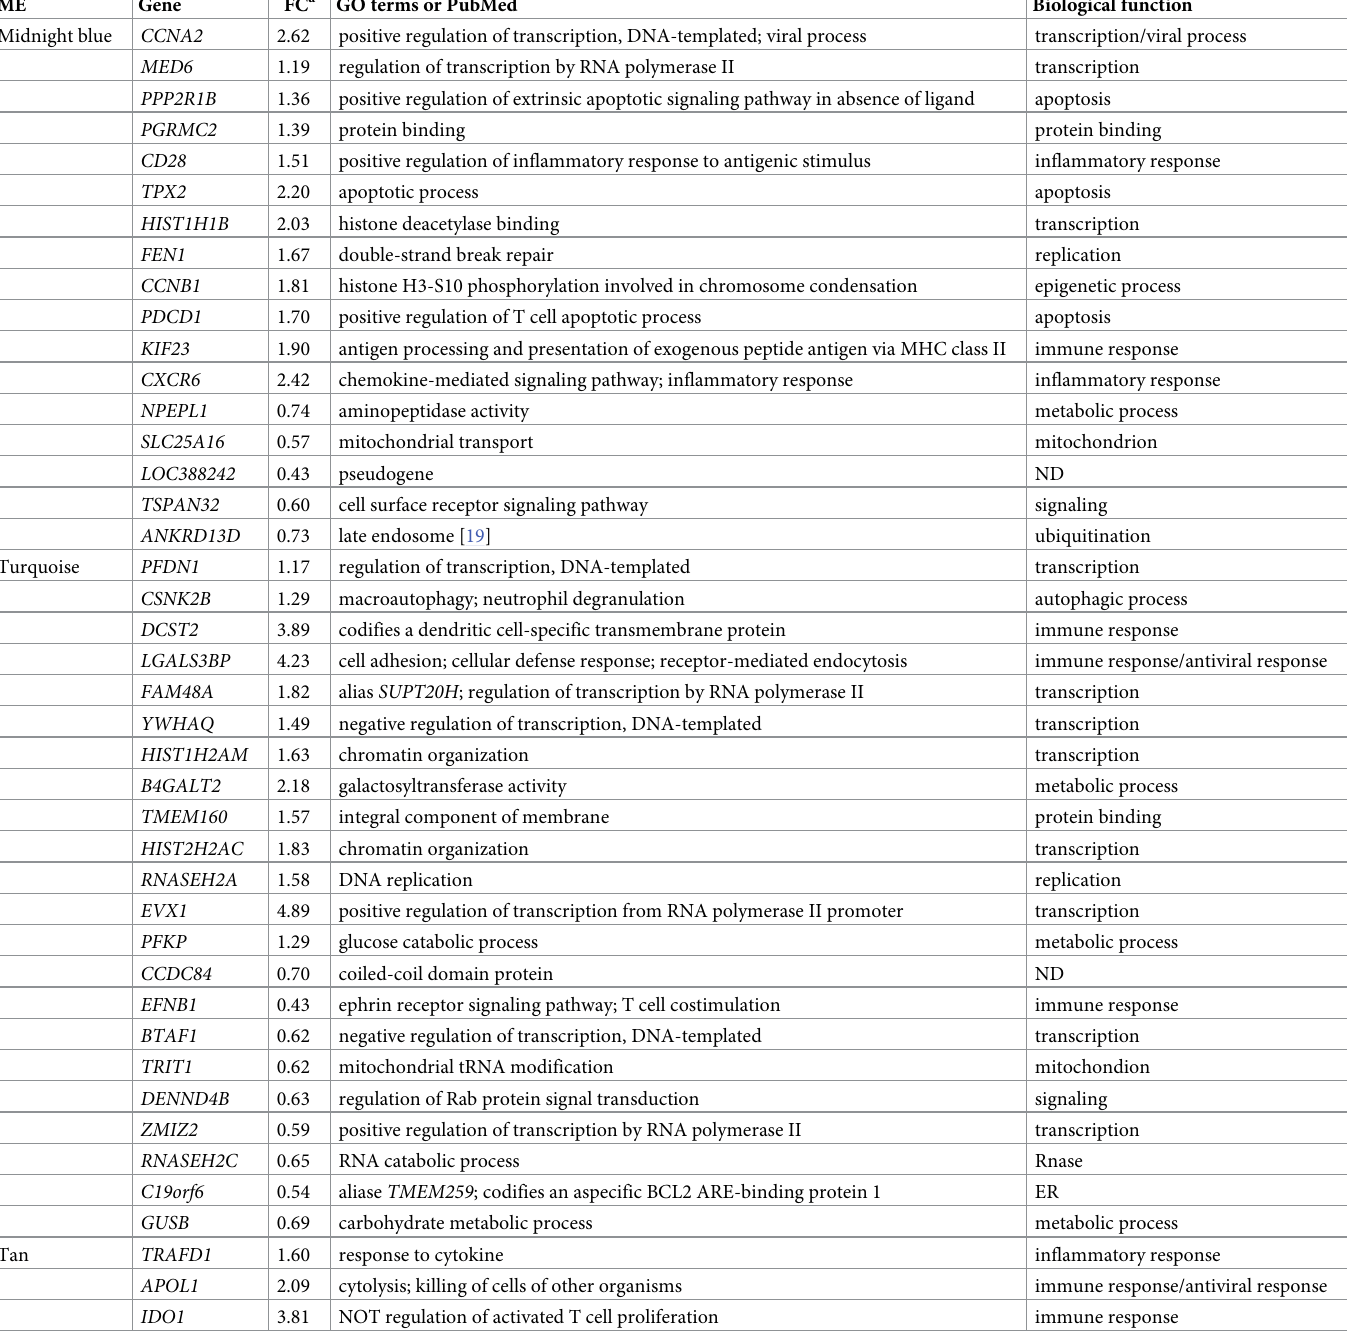
Table 3. Functional description of the HGS-hub genes in modules highly and positively associated with HRSV group. ME Gene FC a GO terms or PubMed Midnight blue CCNA2